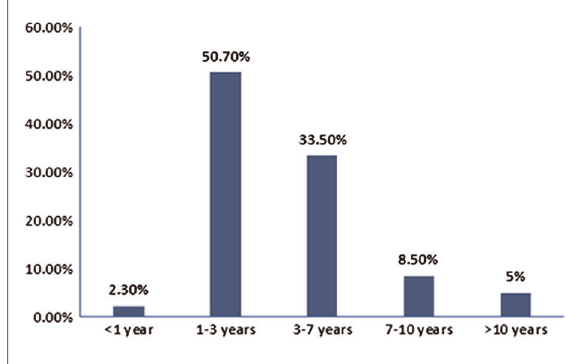
FIGURE 1 Childhood-onset myasthenia gravis onset age distribution. The number of patients were calculated based on the onset age. Of 343 cases, 174 had onset age between 1 and 3 years, 8 less than 1 year, 115 between 3 and 7 years, 29 between 7 and 10 years, and 17 older than 10